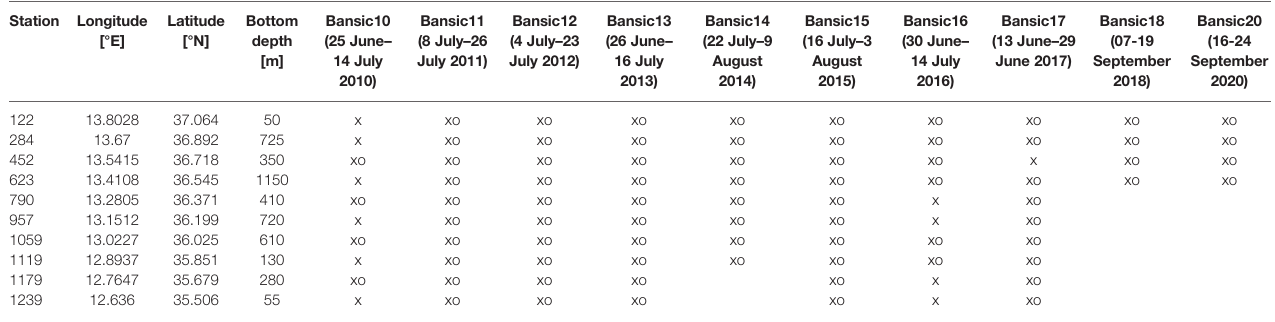
TABLE 1 | Oceanographic surveys carried out in the sicily channel and relative sampling activities (x_CTD and o_nutrient analysis) carried out in the 2010-2020 period. Station Longitude Latitude Bottom [°E] [°N] depth